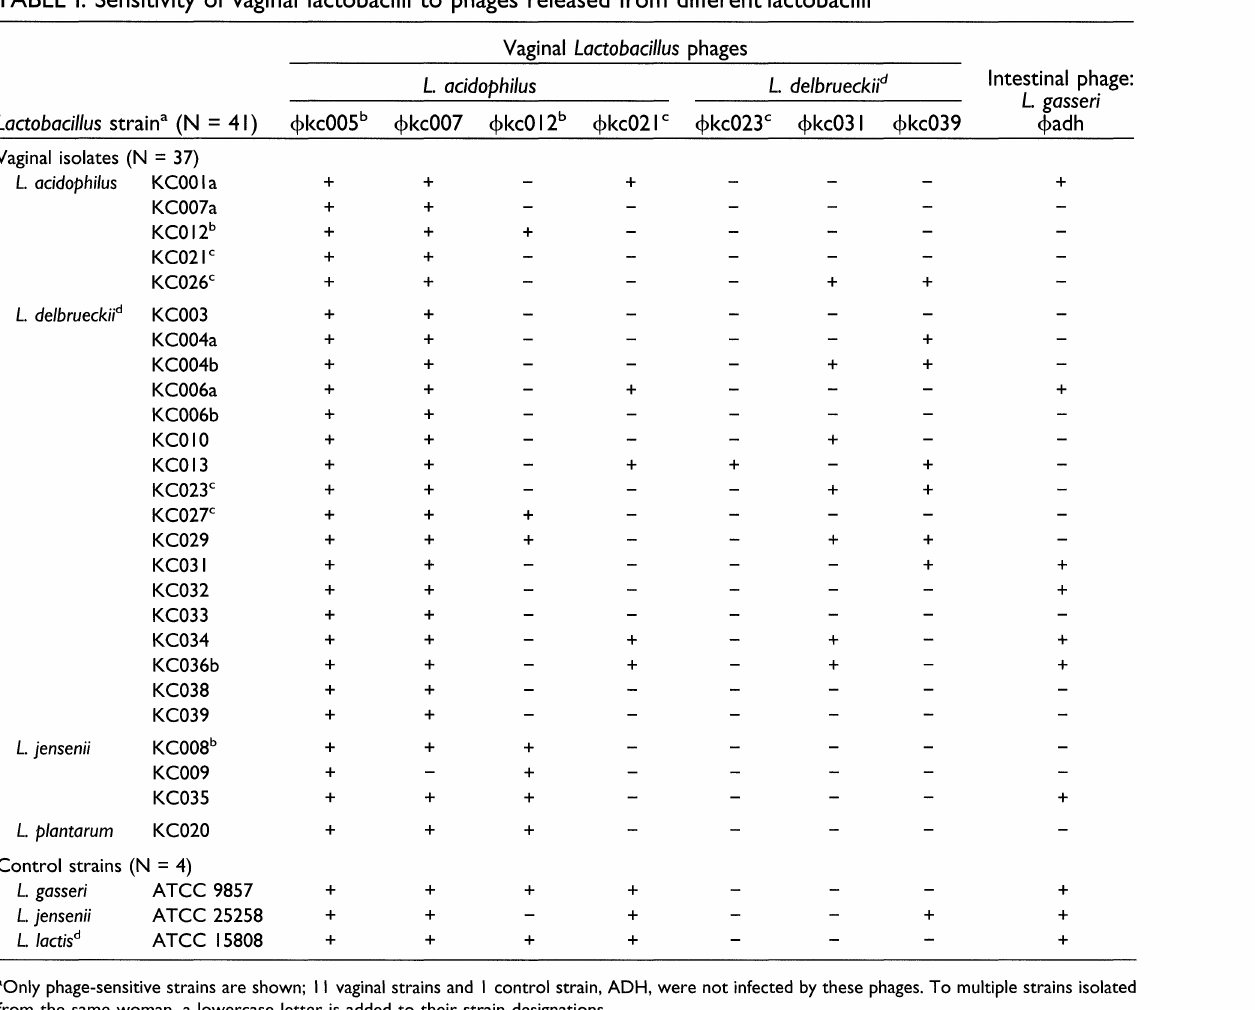
Lactobacillus strain